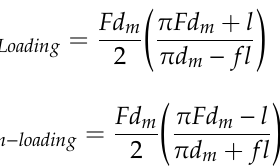
Figure 6. Experimental investigations on the axial stiffness; an experimental setup in ( a ) side view, and ( b ) top view, and ( c ) a plotted graph of deformation versus the reaction force (Black line: simulation result, Red dotted line: experiment result).